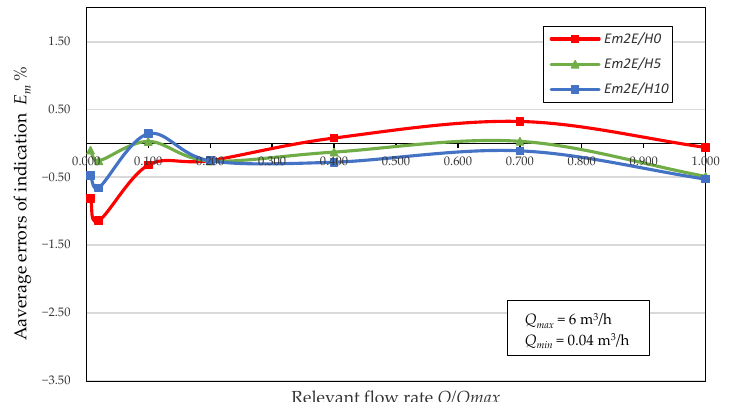
Figure 6. Average errors of indications of G4 ultrasonic gas meters tested with different gas mixtures as a function of relative flow rates Q/Q max .